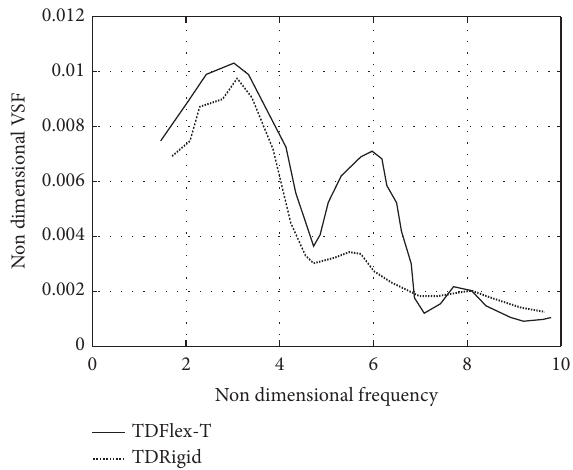
Figure 11: Comparison of rigid body and hydroelastic RAO of VSF for the ULC at